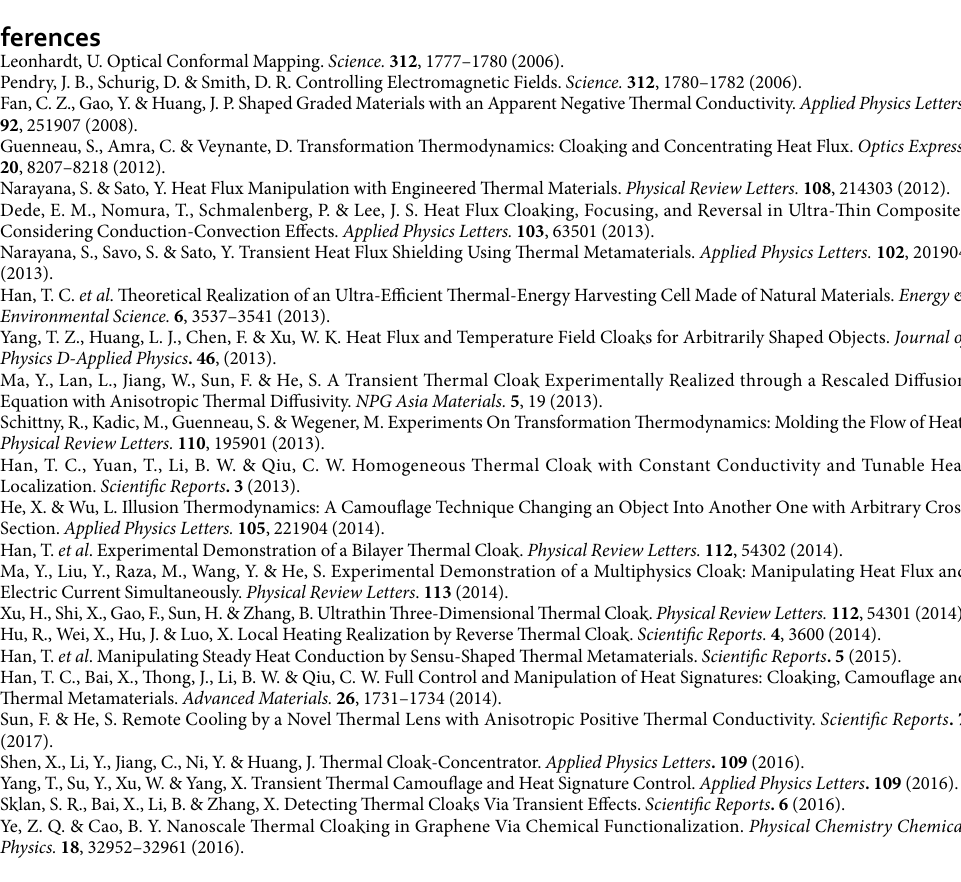
method has been validated by simulations on a designed system consisted of stainless steel as background mate- rial, and it can be also used to other cases. The effect of the device dimension on the thermal conductivity and anisotropy required in the device is discussed. Some structures are proposed as the unit cells of the artificial materials to meet the requirement for the thermal conductivities in the device. In addition, the possible effects of the simplified structures and the interface thermal resistance in fabrication process are discussed by simulations.